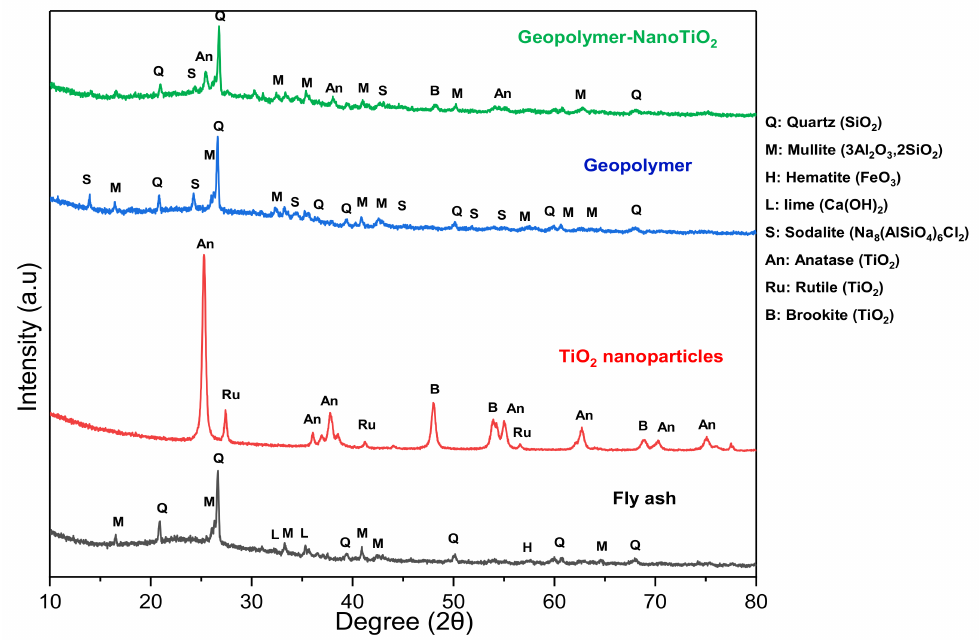
Figure 1. XRD spectra of fly ash, TiO 2 nanoparticles, geopolymer, and geopolymer-NanoTiO 2